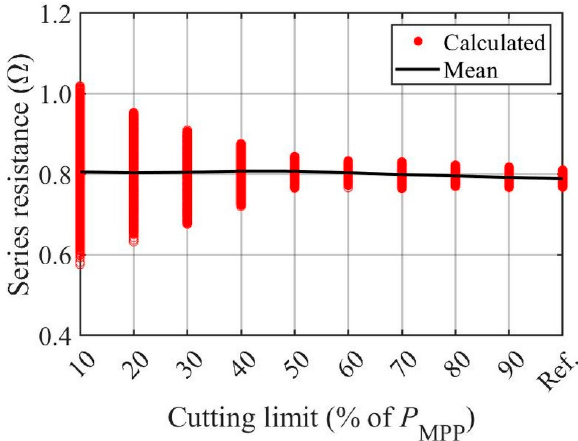
Figure 7. Fitted series resistance values during the 40 min measurement period obtained by fitting the single-diode model to the entire I – U curves with 100 representative points.